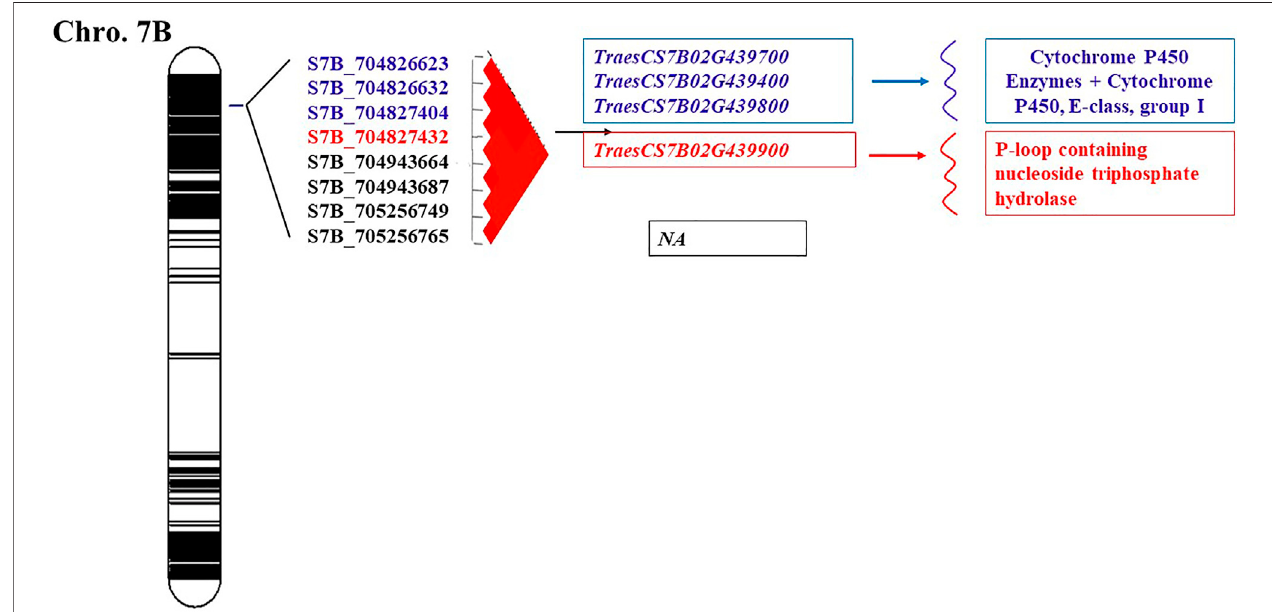
FIGURE 6 | The schematic representation of genomic regions map on chromosome